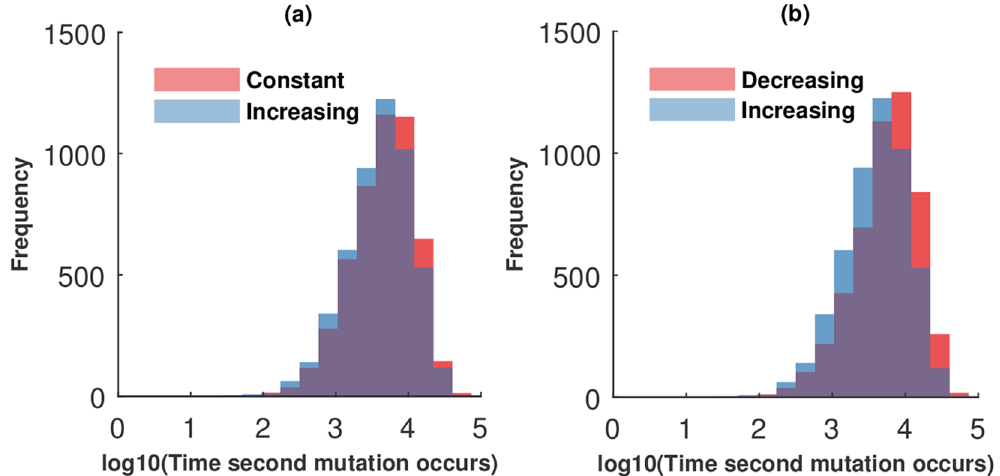
Fig 7. Distribution of the generation times to second mutation, obtained from stochastic simulations, in the case where v depends on the compartment sizes. We perform 5000 stochastic simulations and compare two arrangements of the compartment sizes: (a) constant compartment size (red bars) and increasing (blue bars); (b) decreasing (red bars) and increasing (blue bars). Compartment sizes are as in Fig 6. The self-renewal probabilities are v 1 = 1, v 3 = 0, v We assume n = 3 and u = 0.001. In part (a), the mean time to a two-hit mutant for constant and increasing architecture is 3.65 and 3.59 respectively; the p value obtained by a two-tailed t -test is p (cid:28) 0.001, the effect size is 0.12. In part (b), the mean time to a two-hit mutant for decreasing architecture is 3.73; p (cid:28) 0.001; the effect size is